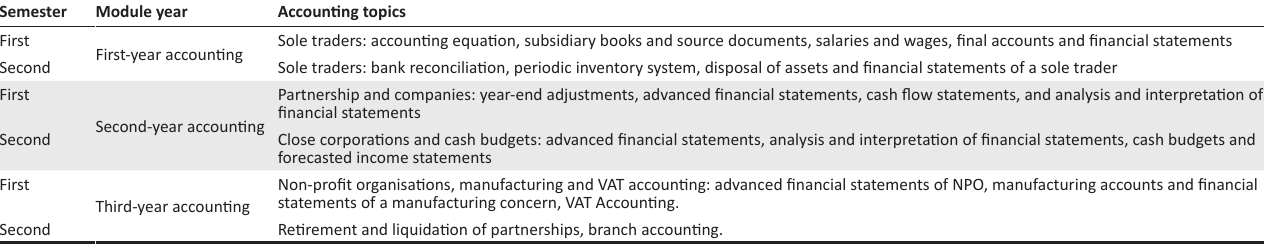
FIGURE 1 : Polya’s four steps for solving word problems. TABLE 2: Bachelor of Education Accounting curriculum at higher education